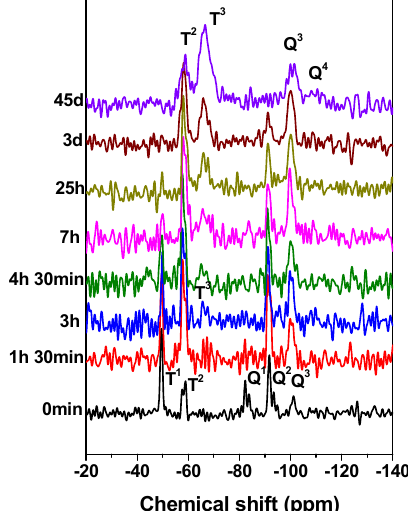
Figure 4. 29 Si NMR spectra for the polysiloxane hybrids synthesized from [TMOS]/[MPTS] mixture at room temperature for different times.